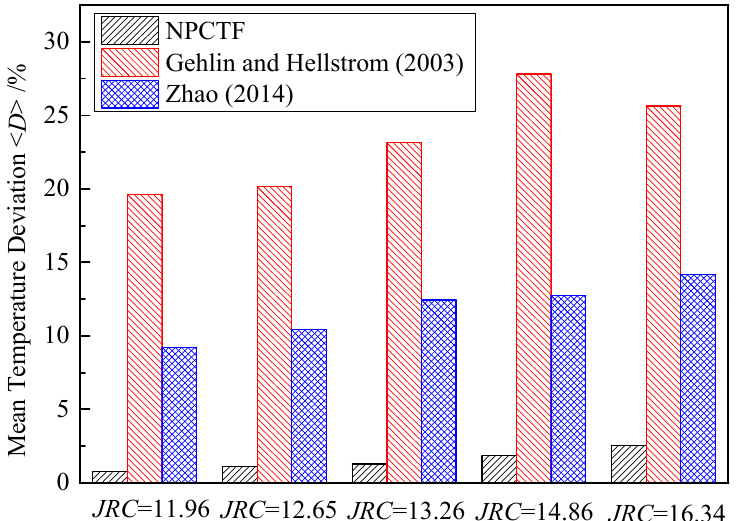
Figure 11. Mean deviation from heat flow simulations <D> for the proposed NPCTF, Gehlin and Hellstrom (2003) [2], and Zhao (2014) [35] models.